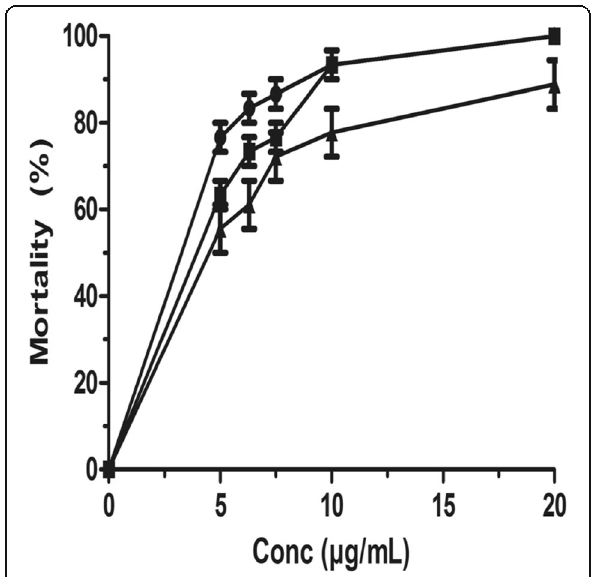
Fig. 2 Activity against C. elegans with reference drugs 72 h post-exposure: ( ● ) Ivermectin, ( ▲ ) Albendazole, ( ■ ) Levamisole. Data are mean ± SEM from three independent duplicate